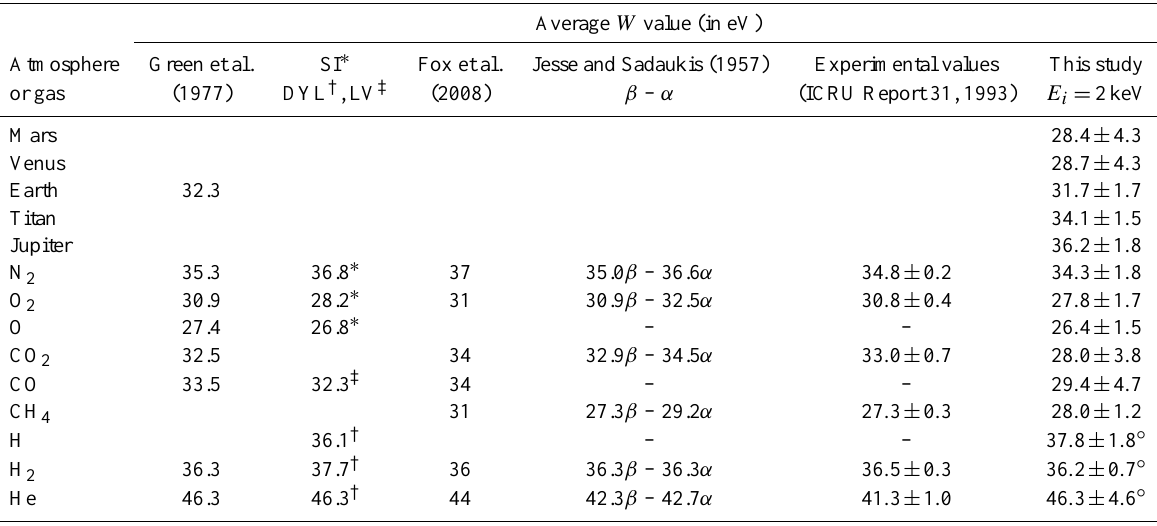
Table 1. Energy per ion pair for planets and gases. SI=Sergienko and Ivanov (1993) for N 2 , O 2 and O. DYL=Dalgarno et al. (1999) for H, H 2 and He. LV=Liu and Victor (1994) for CO. The uncertainties for W (He) reach 10% at 2keV input energy, this is due to a combination of energy conservation in the solving scheme as well as on the cross sections. W (Jupiter) and W (H) have uncertainties of the order of 5%. W (O 2 ) has an uncertainty of 6%, which affects in turn W (Earth), W (Mars) and W (Venus). N 2 , O, CO 2 and CO W values have uncertainties of 8%, 5%, 13% and 15% when taking cross sections uncertainties and energy conservation into account. Experimental values are taken from ICRU Report 31 (1993) for electrons and from Jesse and Sadaukis (1957) for β and α particles as the ionisation source, given here for comparison (uncertainties claimed to be 1.5%). Note that W (He), W (H 2 ) and W (H) uncertainties, highlighted by the symbol ◦ , are only due to the numerical scheme (energy conservation) and are a lower